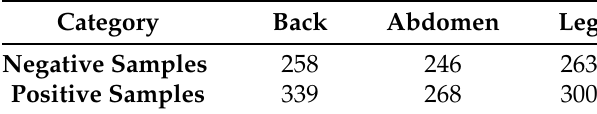
Table 2. Suspicious objects Detection